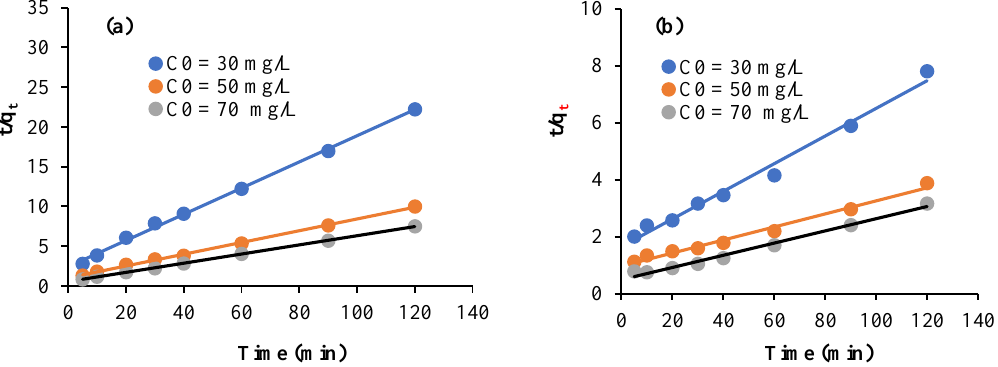
Figure 7. Plots of second-order kinetic model for: ( a ) pectin beads and ( b ) pectin-[Sb(TPP)Cl 2 ] beads (1%).